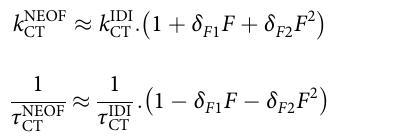
force increase (i.e., more negative Δ G increases k CT . In the ‘ inverted ’ region ( (cid:2) Δ G the driving force reduces k CT as the activation energy decreases.